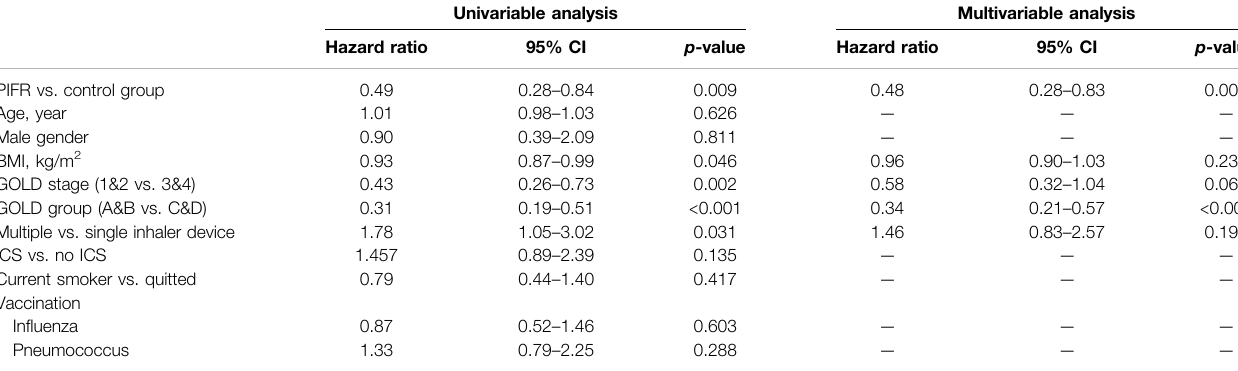
TABLE 3 | Factors associated with the risk of severe exacerbation within one